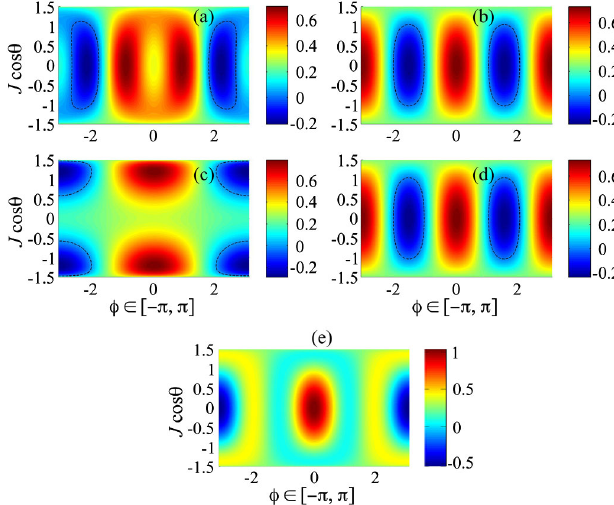
equals ð D (cid:2) 1 Þ 2 = 2 , as seen in Fig. 14. In either case, this is